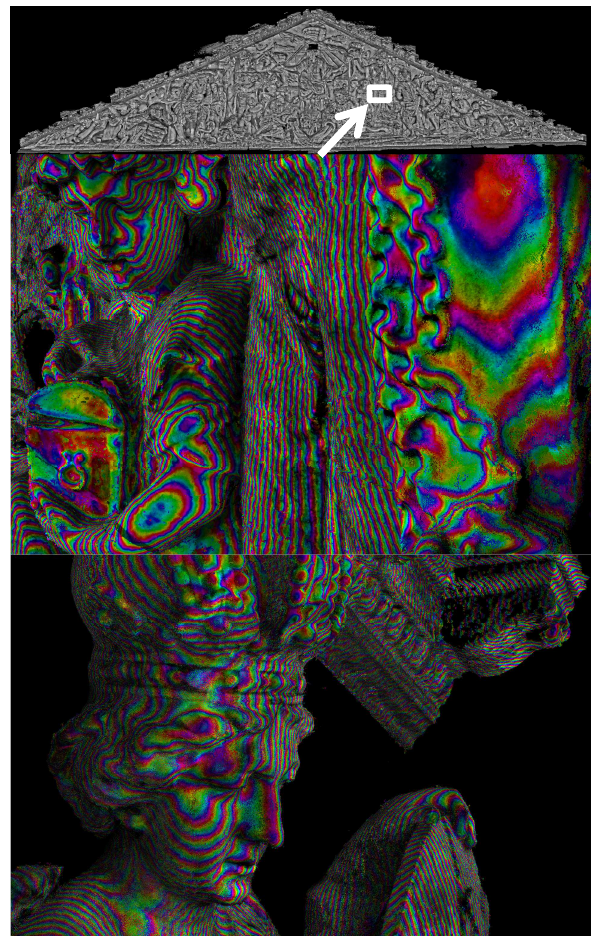
Figure 8: Point cloud of the tympanum at the west façade with about 1.1 billion points and a detail. Third image: detail from the east